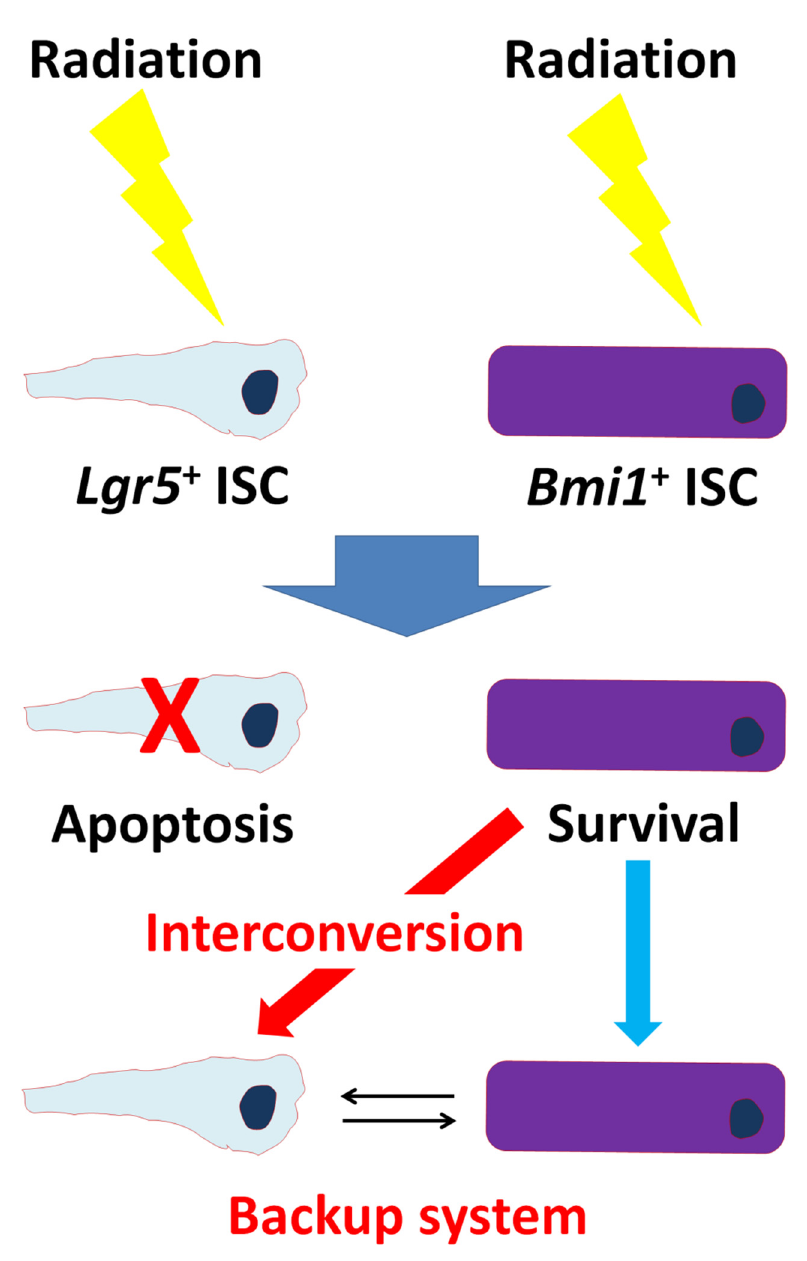
Figure 2. Backup system between Lgr5 + and Bmi1 + ISCs. Upon radiation, Lgr5 + ISCs undergo apoptosis, forcing Bmi1 + ISCs to assume a dominant role. During recovery from radiation, Bmi1 + ISCs give rise to Lgr5 + ISCs to restore homeostasis. Three-dimensional (3D) intestinal organoids are organized by crypt cells from mouse small intestines with specific conditions (Figure 3). Intestinal organoids are embedded in Matrigel and cultured with biochemical factors such as epidermal growth factor (EGF), Noggin (a bone morphogenetic protein inhibitor), and R-spondin 1 for mimicking the in vivo ISC niche [12]. Curiously, a single ISC including an Lgr5 + or Bmi1 + stem cell can also generate a crypt-villus domain containing spherical bodies in the absence of an intestinal